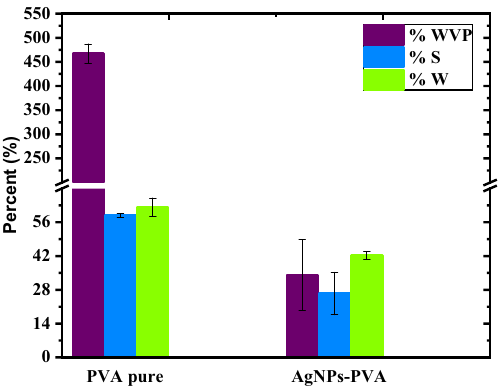
Figure 7. Moisture content, water vapor permeability, and water contact angle of agar and agar/cellulose composite film.